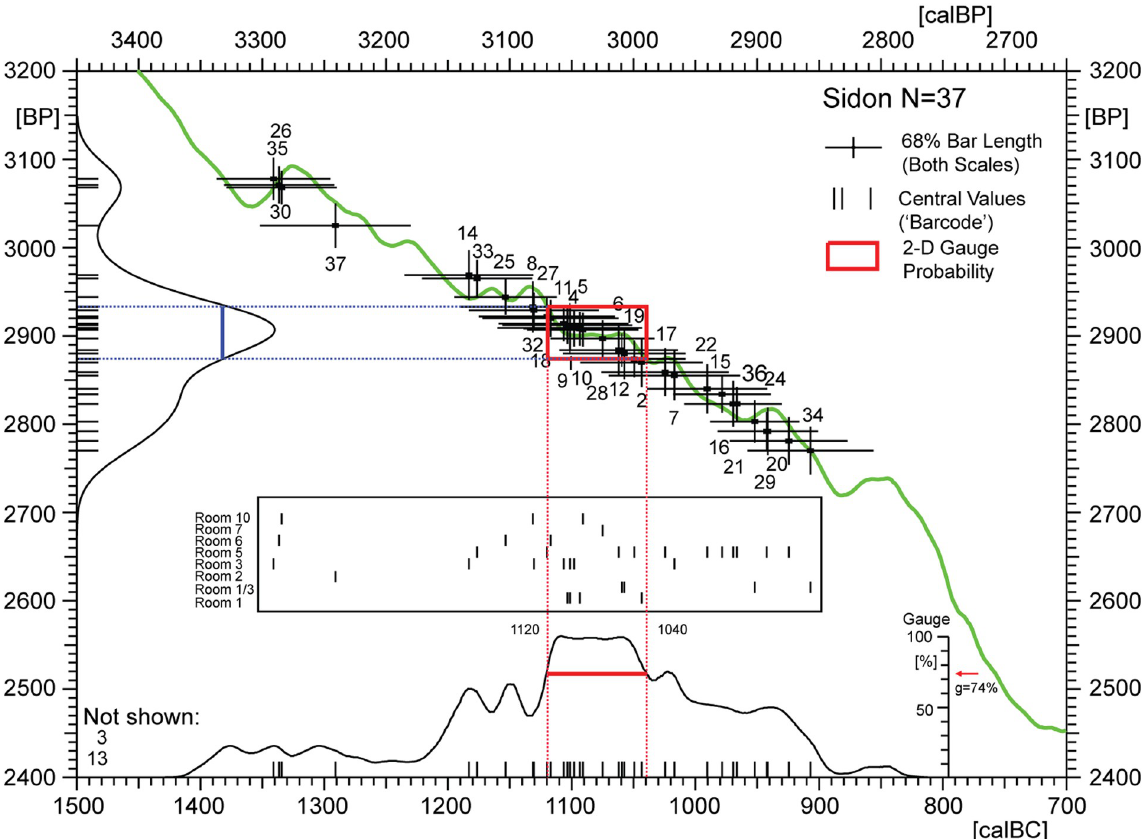
Fig 10. Overview (dispersion diagram) of radiocarbon ages from Sidon (N = 37, Table 1) showing the individual 14 C-ages as calibrated crossbars with identification numbers (ID1-37). Also shown are the 14 C-histogram and the summed calibrated 14C-age probability distribution (SPD) of the total data. Calibrated median values of the single 14C ages are shown in barcode representation for total data on the calendric timescale (small vertical lines underlying the SPD envelope). In the centre of the graph the data is re-arranged according to Sidon- rooms (Room 1,1/3, 2, 3, 5, 6, 7, 10). When interpreting such diagrams it important to note that barcode ages (defined as central values of 95%- confidence intervals) are only useful for overview purposes, due to the folding properties of the 14C age calibration curve and related age- distortion (centennial-scale) of calendric ages and probability